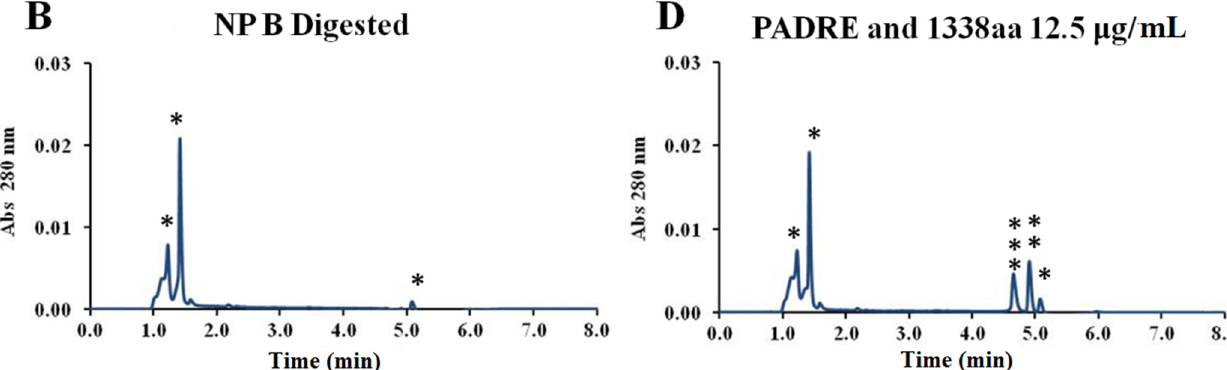
Figure A1. Comparison between UPLC peaks from digested blank nanoparticles and peptide-loaded nanoparticles, and the free PADRE and 1338aa peptides in digested nanoparticle matrix. Comparison between UPLC peaks of digested peptide-loaded nanoparticles ( A ) encapsulated ( B ) surface adsorbed) with blank nanoparticles ( C ) and with free PADRE and 1338aa peptides in digested nanoparticle matrix as controls ( D ); *: Peaks from residues of digested nanoparticles; **: Peak from PADRE peptide; ***: Peak from 1338aa